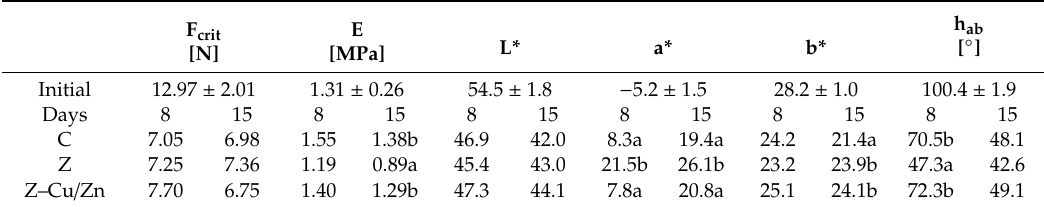
Table 4. Texture and color evolution of tomatoes stored at 20 ◦ C without (control), in the presence of zeolite (Z) or modified zeolite (Z–Cu / Zn) 1